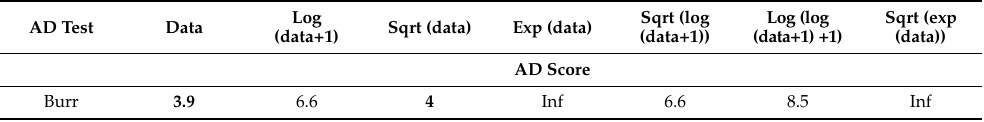
Table 14. IAT > 1 s, Split Count = 1: AD Test.